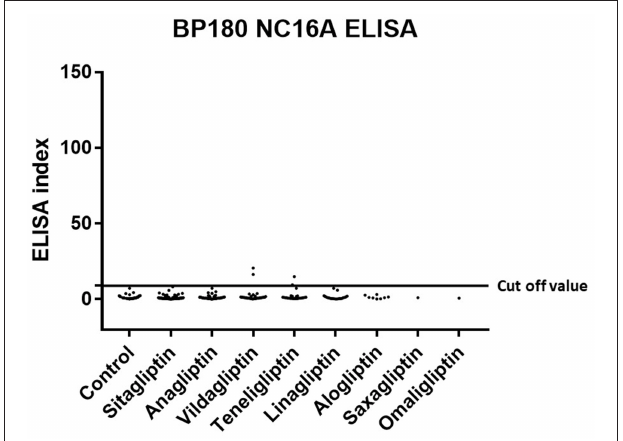
FIGURE 3 | Type 2 diabetes mellitus. Scatter plot of BP180-FL ELISA index in DPP-4i (–) and DPP-4i ( + ). Cut-off value of BP180-FL ELISA < 4.64, Control indicates the DPP-4i (–) group.